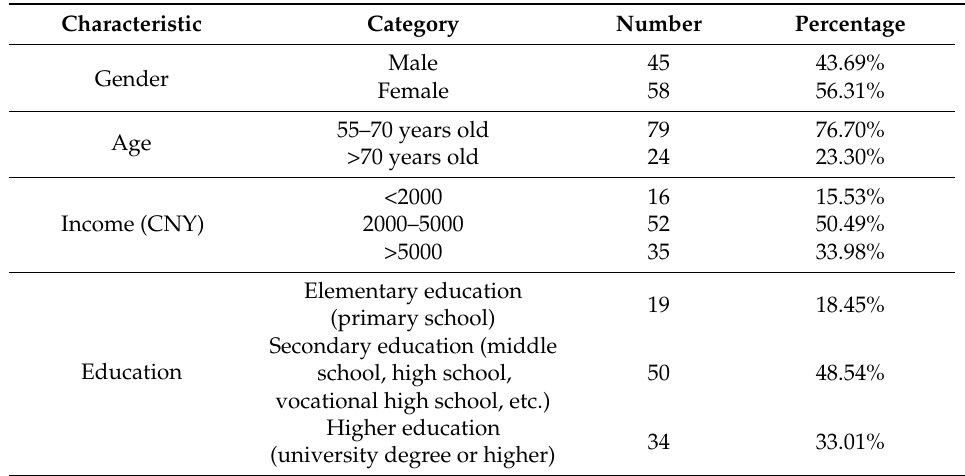
Table 5. Basic information of